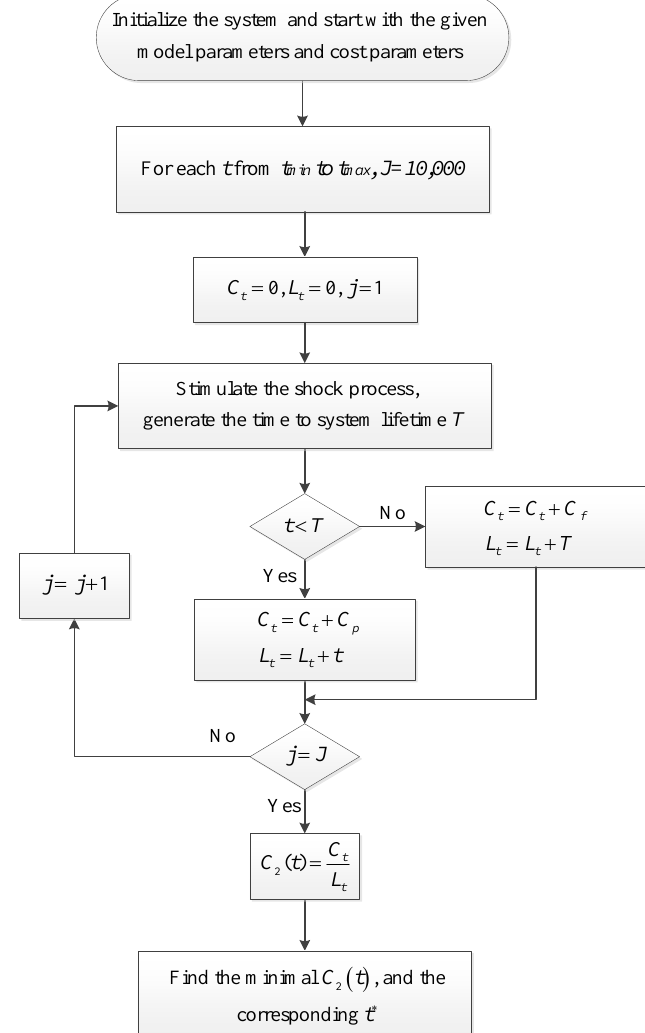
Figure 3. Simulation flowchart under maintenance policy 2.